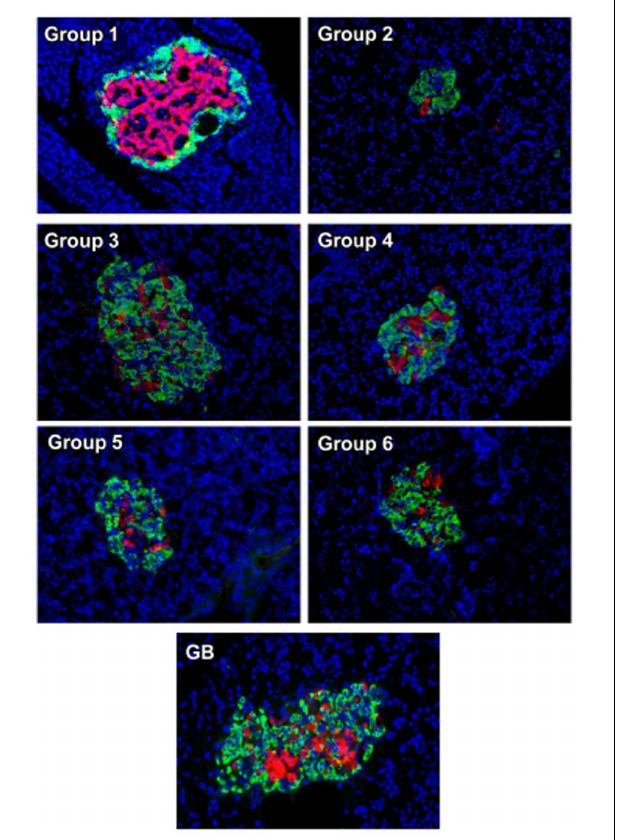
FIGURE 6 | Immunohistochemical analysis of insulin ( red ) and glucagon ( green ) in pancreatic islets of experimental groups. Nuclei are counter-stained with DAPI ( blue ). Magnification × 20. Group 1: normal control; Group 2: diabetic control; Group 3: diabetic rats + crude extract; Group 4: diabetic rats + dichloromethane fraction; Group 5: diabetic rats + butanol fraction; Group 6: diabetic rats + aqueous fraction; GB: diabetic rats +